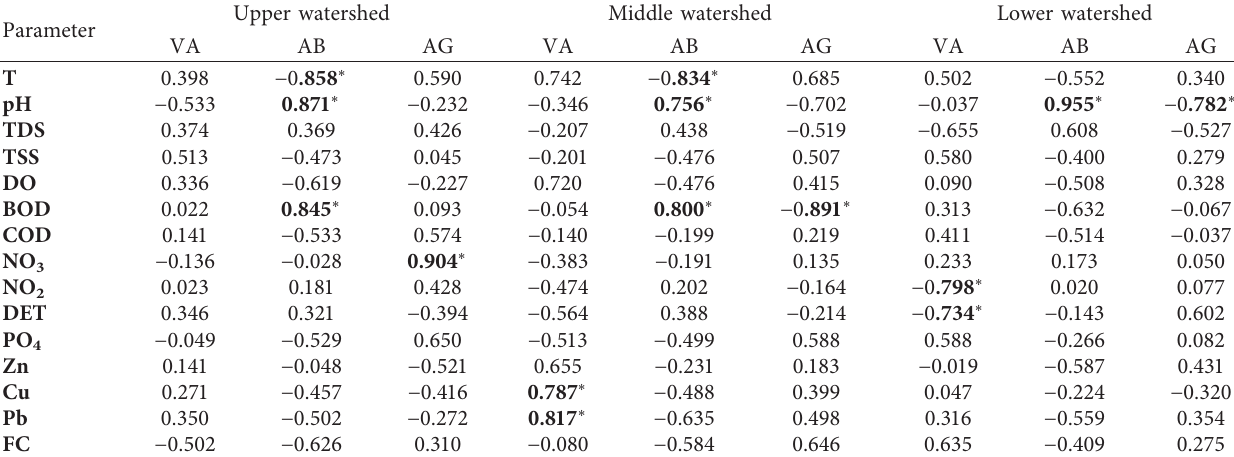
Table 4: Pearson correlation coefficients between the LULC and water quality parameters.